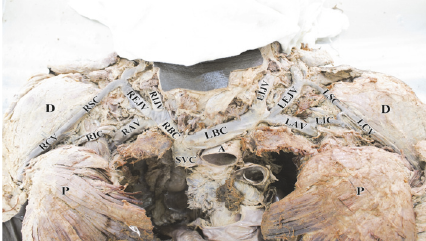
Figure 2: Dissected body with the clavicle removed. It shows the right and left internal jugular vein (RIJV and LIJV), right and left external jugular vein (REJV and LEJV), right and left supraclavicular (RSC and LSC) branches of cephalic vein, right and left cephalic vein (RCV and LCV), right and left infraclavicular (RIC and LIC) branch of cephalic vein, right and left axillary veins (RAV and LAV), right and left brachiocephalic vein (RBC and LBC), superior vena cava (SVC), aorta (A), deltoid muscle (D), and pectoral major muscle (P).